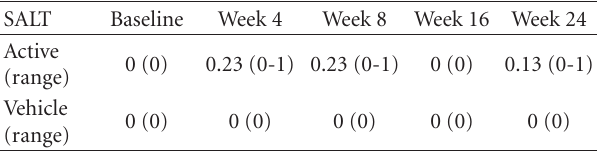
Table 10: Mean Subject’s Local Tolerability Assessments